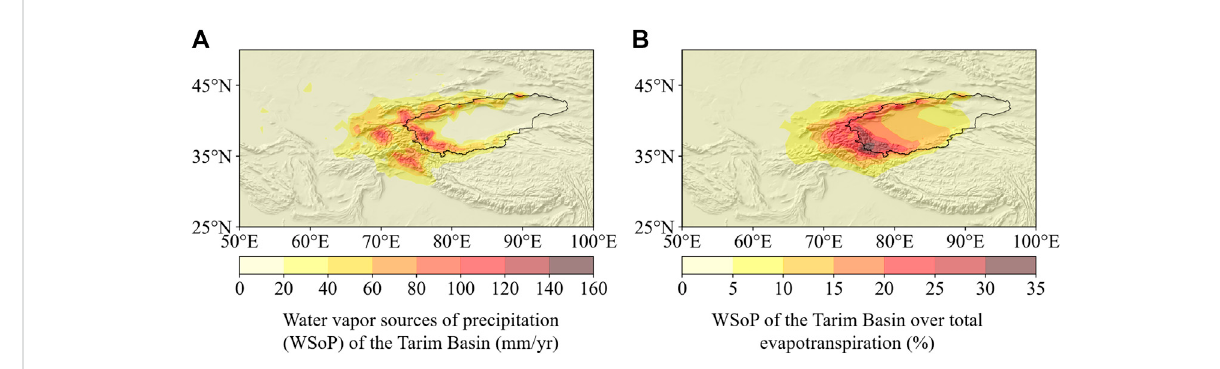
FIGURE 2 Multi-year (1980 – 2018) mean spatial distribution of precipitation sources of the Tarim Basin: (A) water vapor sources of precipitation; (B) contribution ratio of evapotranspiration.